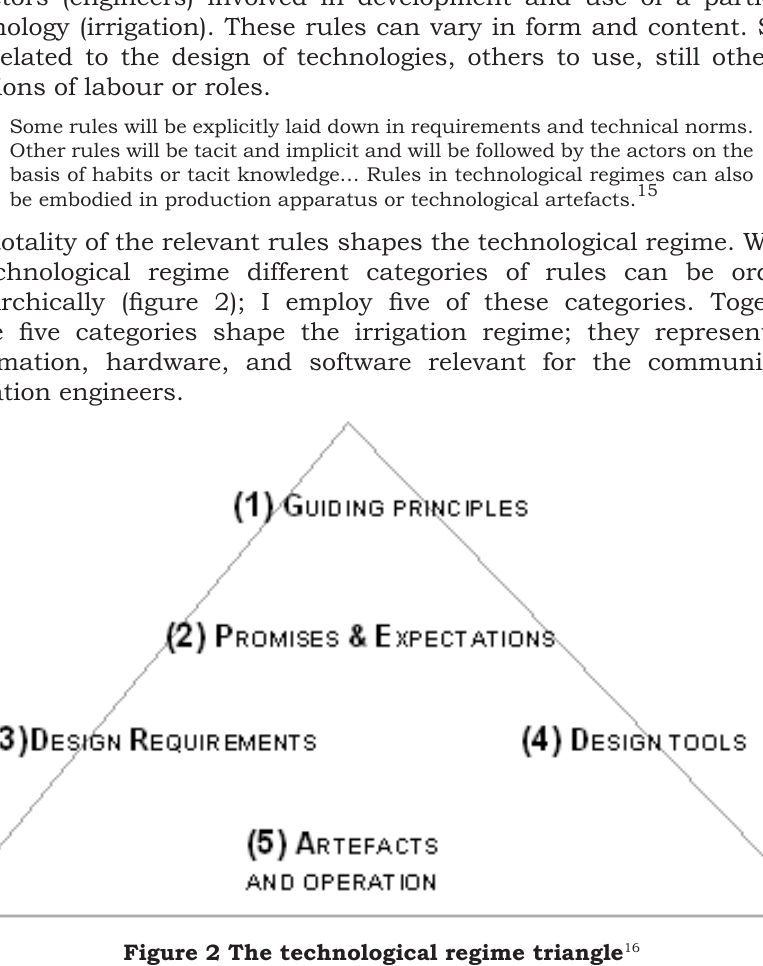
Figure 2 The technological regime triangle